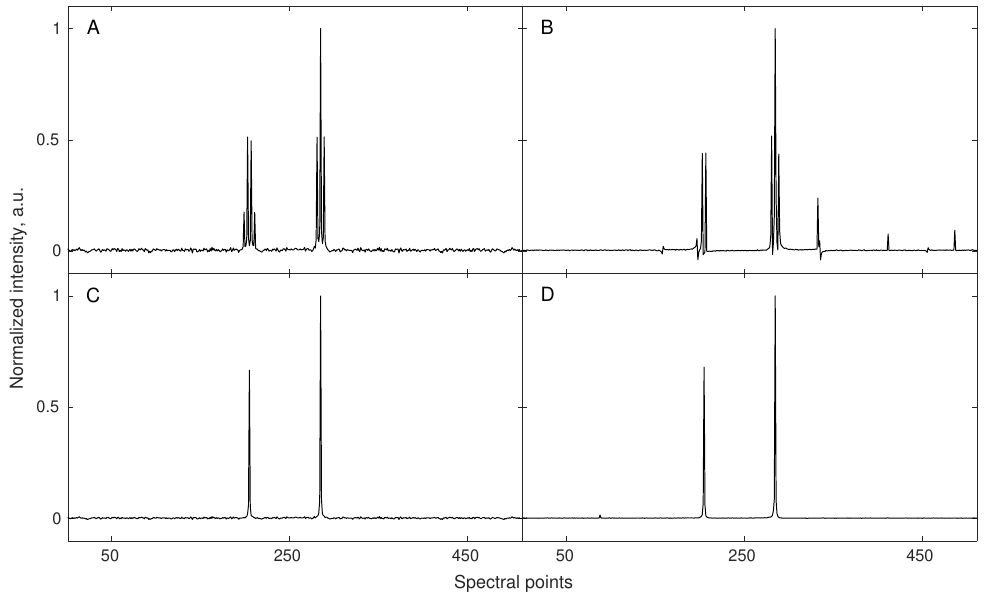
Figure 1. A simulation showing gains from the enhanced compressibility of the NMR spectrum obtained with pure-shift method. A conventionally sampled signal of 512 points length, containing 7 components (see corresponding triplet and quartet in spectrum ( A )) was sub-sampled to 32 random points and reconstructed using 40 iterations of iteratively re-weighted least squares [20] algorithm ( B ). In this case, the sampling level turned out to be too low resulting in wrong reconstruction. A fully sampled (512 points) pure-shift experiment shows multiplets collapsed into the singlets (spectrum ( C )). The corresponding reconstructed spectrum ( D ) obtained using the same sub–sampling scheme and reconstruction parameters as for ( B ) reveals to be of good quality. Reduced number of signal components (enhanced compressibility) allowed for reliable signal reconstruction using the same number of sampling